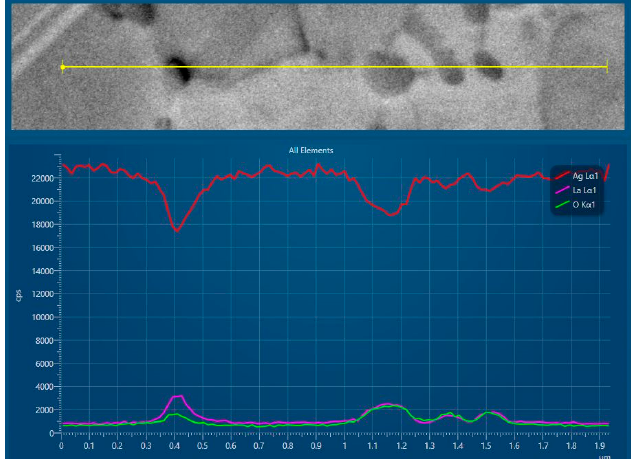
Figure 8. Line microchemical analysis of an internally oxidised ribbon.